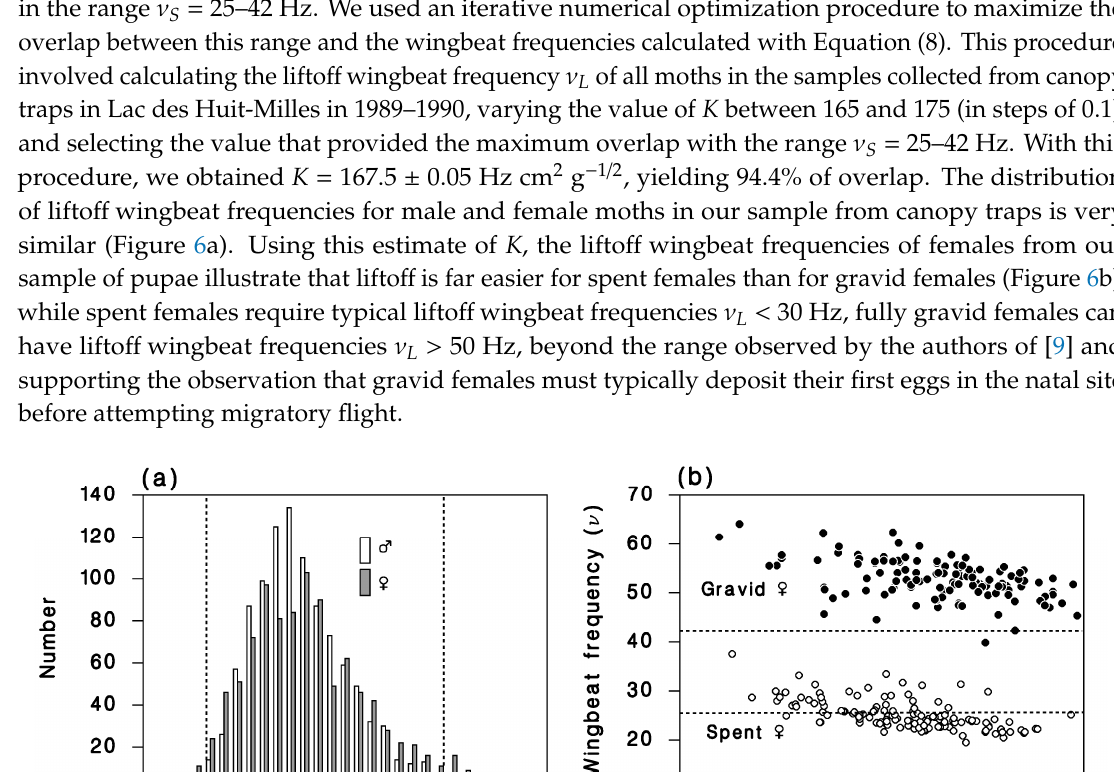
Figure 5. ( a ) Relationship between stand-level variance σ d2 and mean μ d defoliation expressed as a proportion, with the line from Equation (7). ( b – g ) Observed and Beta frequencies of shoot-level defoliation for ranges of stand-level defoliation from 5% to 95%. Data from balsam fir in the lower St. Lawrence region, 2012–2015.